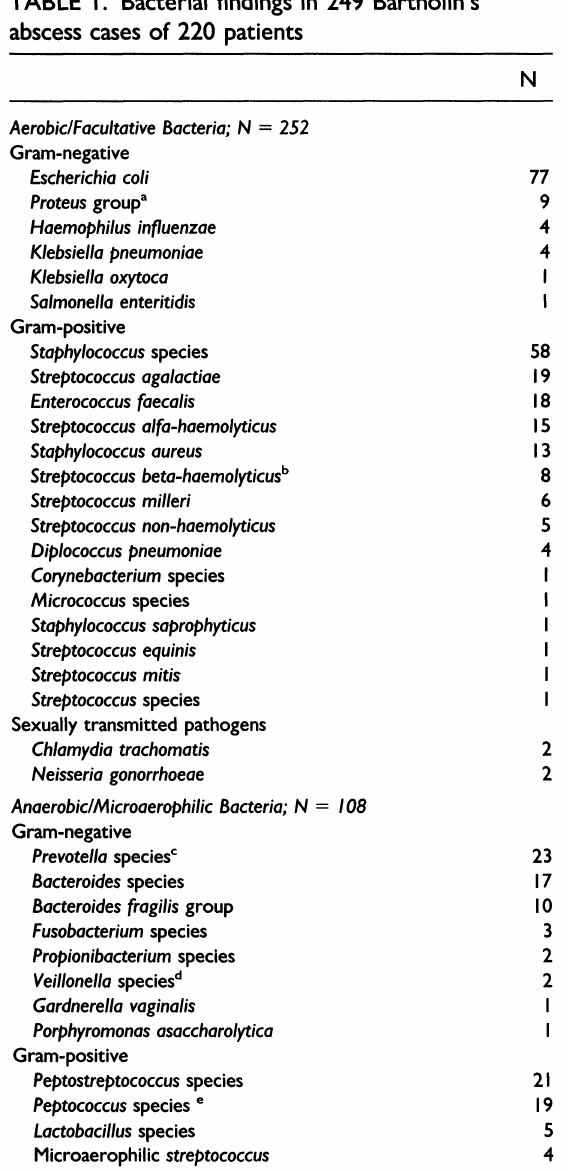
TABLE I. Bacterial findings in 249 Bartholin’s abscess cases of 220